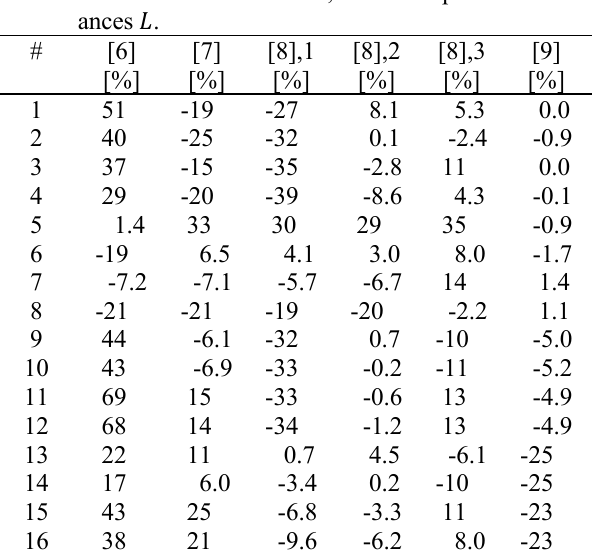
Table 3: Percentaged deviations of the six formulae for the parameter combinations in Tables 1 and 2, num- bered in the same order, from the precise induct- ances 𝐿 .